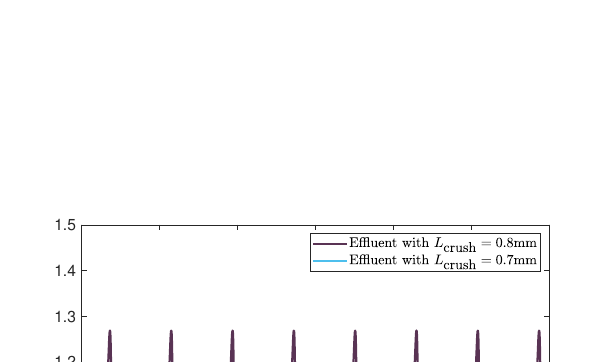
Figure 10: d 50 of the granulator influent/effluent as a response to a step-by-step change of the crusher gap ( L crush = 1 . 1 → 1 . 0 → 0 . 9 → 0 . 8 mm).